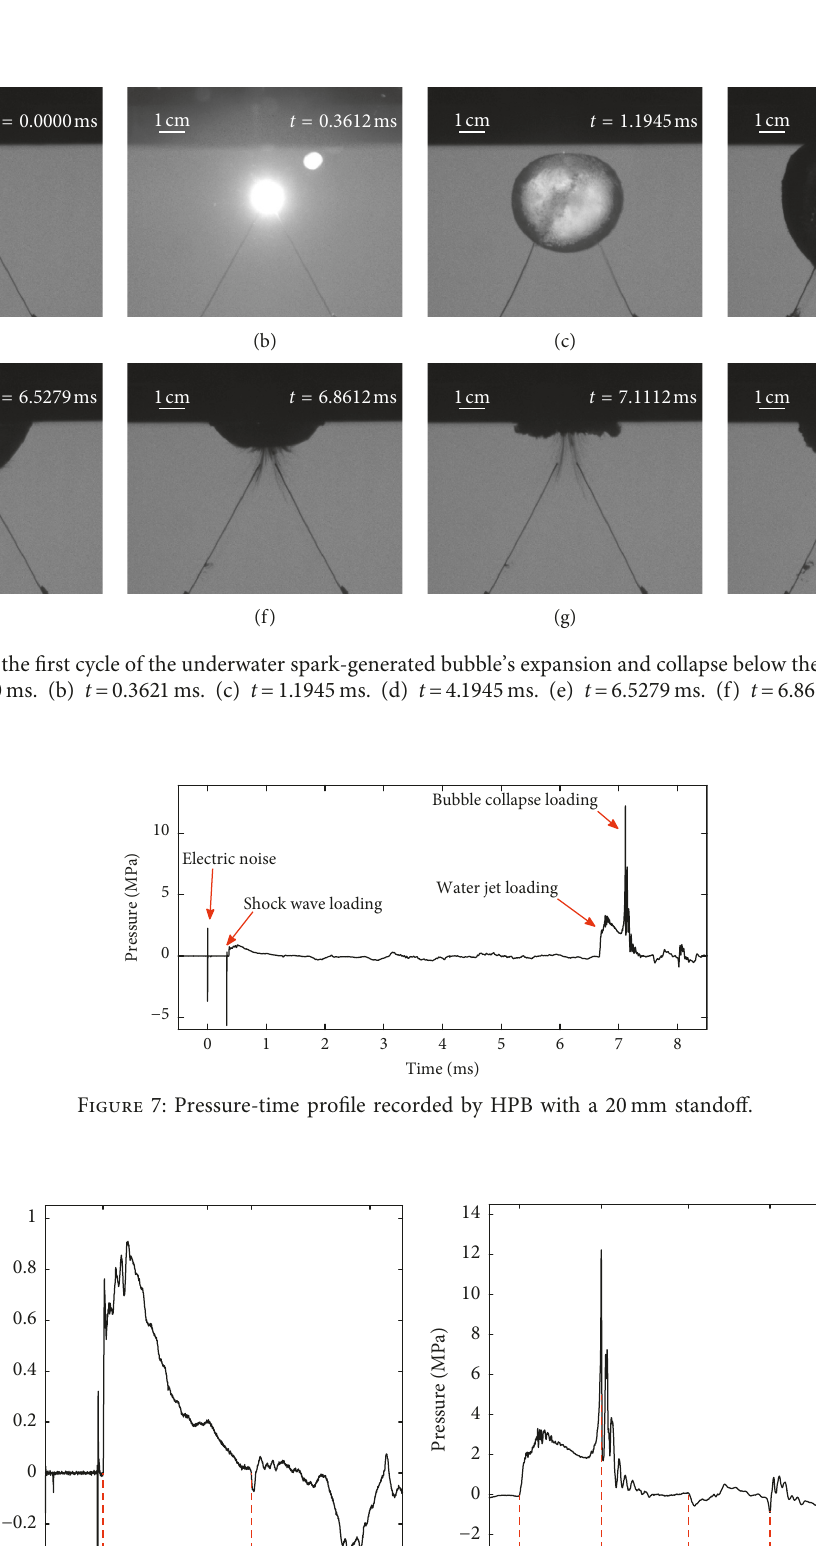
Figure 8: Details of the 20mm standoff pressure-time profile. (a) Shock wave pressure loading. (b) Water jet and bubble collapse